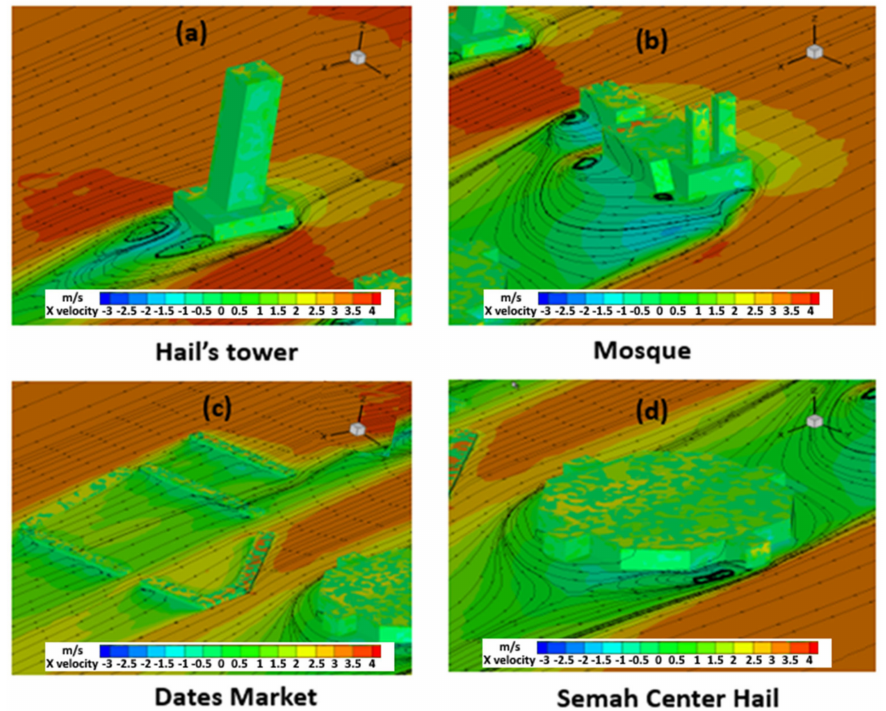
Figure 9. Zoomed view streamlines and X velocity contours: V = 4 m/s, SOUTH direction